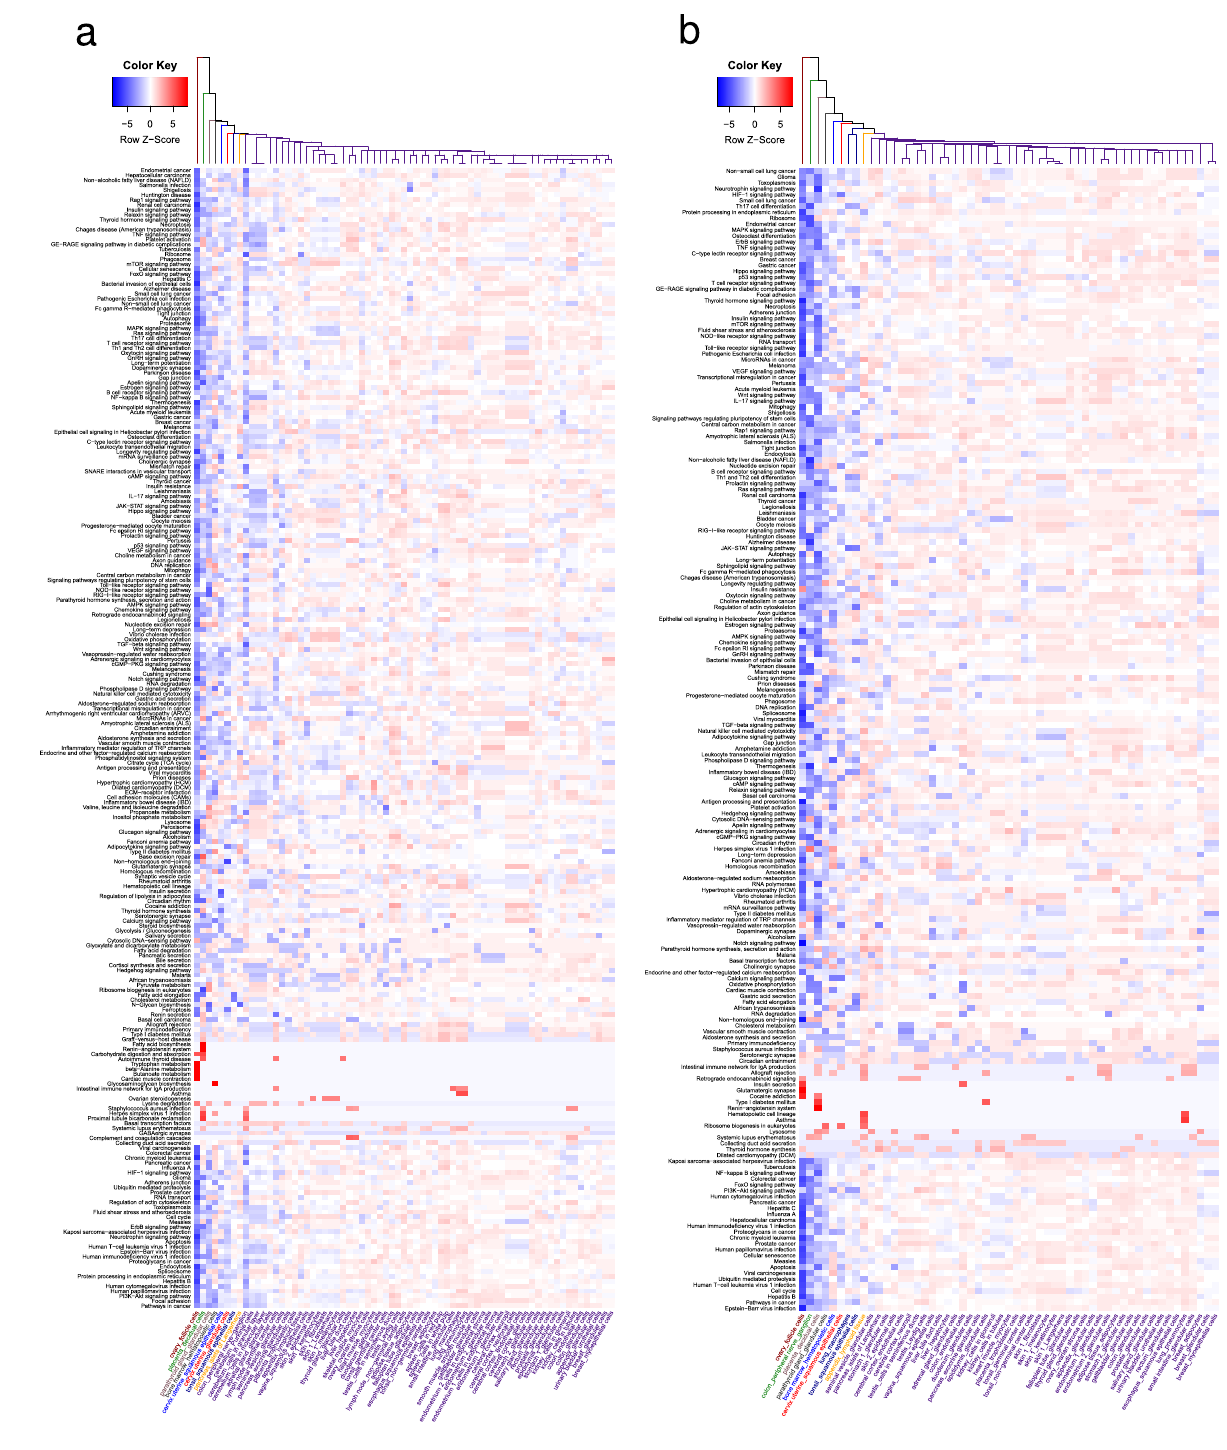
Figure 4. Enrichment of results, KEGG heatmap. ( a ) Signaling pathways in SARS-CoV-2; ( b ) signaling pathways in SARS-CoV-1. The blue color identifies a higher p-value and the red color a lower value (using a logarithmic transformation). A gradient of involvement of the signaling pathways, and therefore of the cells, is identified in both heatmaps from left to right (less altered to more altered,